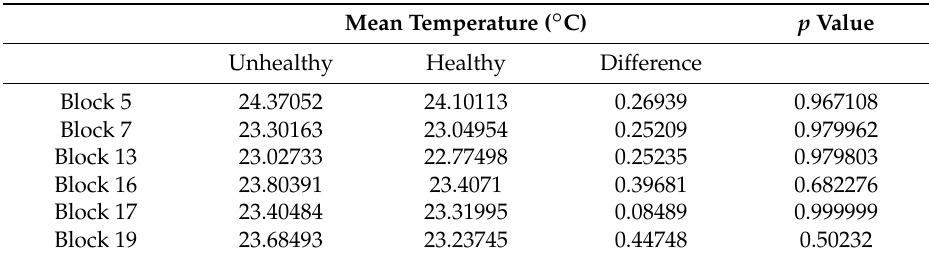
Table 5. Selection of Tukey’s HSD comparing mean temperatures of selected healthy ( n = 10) and unhealthy trees ( n = 10) per block.